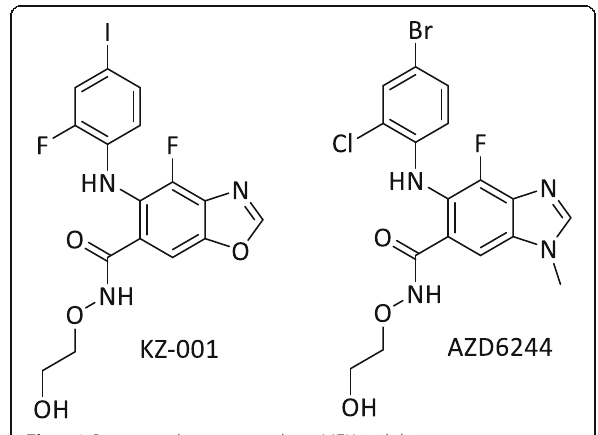
Fig. 48 Benzoxazole compounds as MEK1 inhibitor